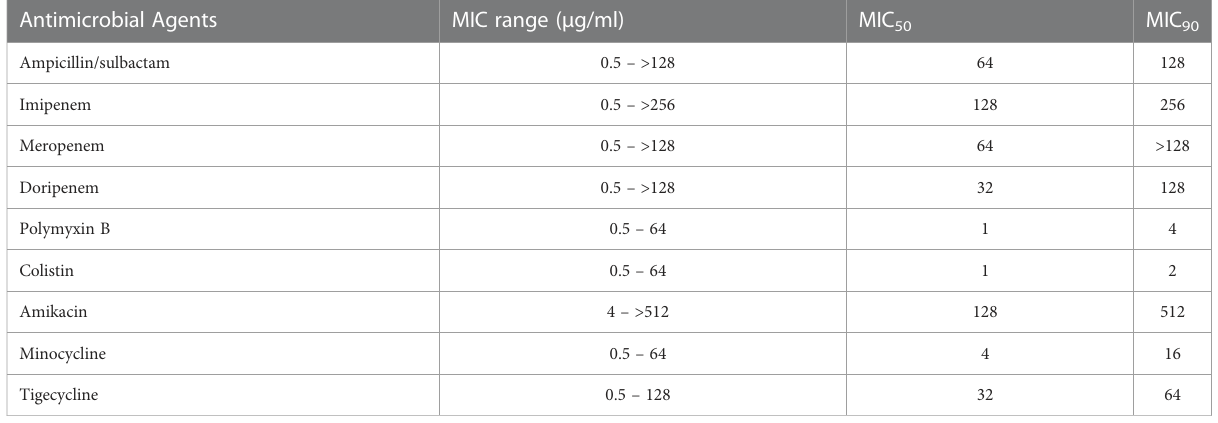
TABLE 2 Minimum inhibitory concentration range, MIC 50 and MIC 90 values of A.baumannii isolates. Antimicrobial Agents